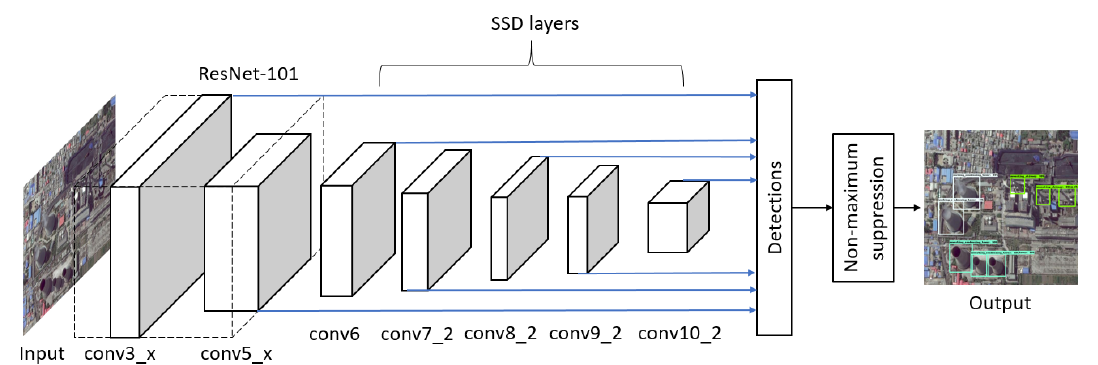
Figure 5. The framework of SSD. Conv, convolutional networks.